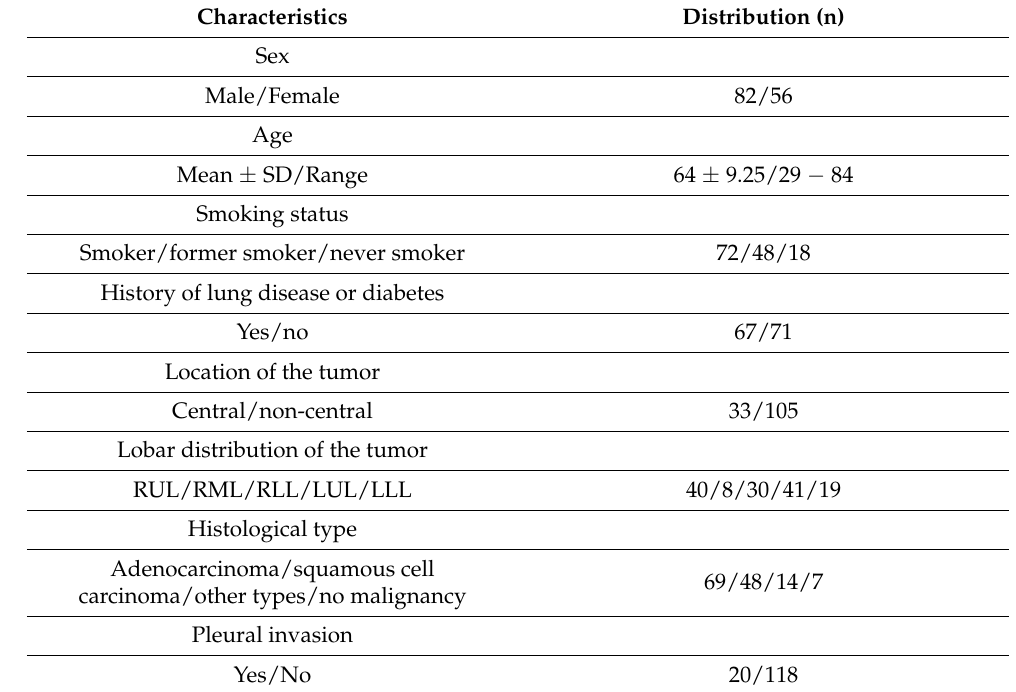
Table 1. Characteristics of patients and tumors ( n = 138). RUL: right upper lobe, RML: right middle lobe, RLL: right lower lobe, LUL: left upper lobe, LLL: left lower lobe, SD: standard deviation.